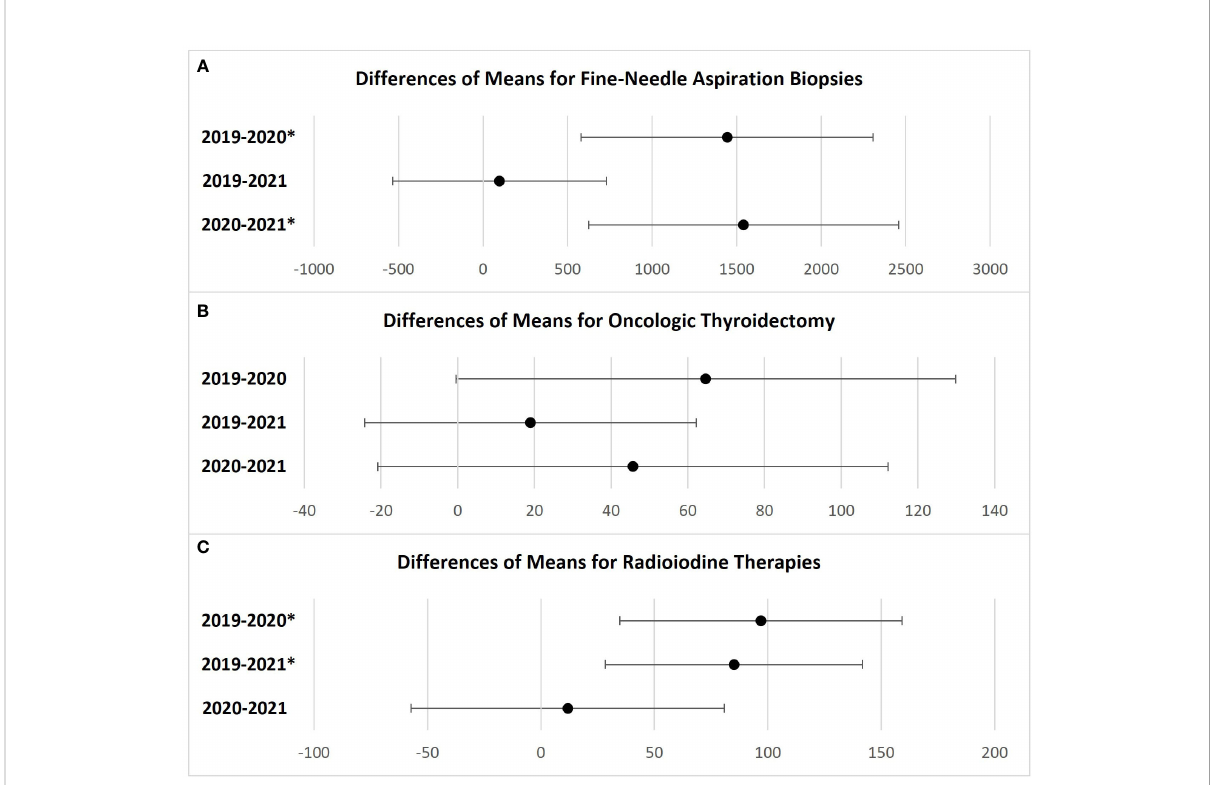
FIGURE 3 Games-Howell post-hoc test. Simultaneous 95% con fi dence intervals of differences between means of each procedure. (A) Fine-Needle Aspiration Biopsies; (B) Oncologic Thyroidetomies; (C) Radioiodine therapies. *Statistically signi fi cant. If an interval does not contain zero, the corresponding means are signi fi cantly different. Differences are expressed as absolute